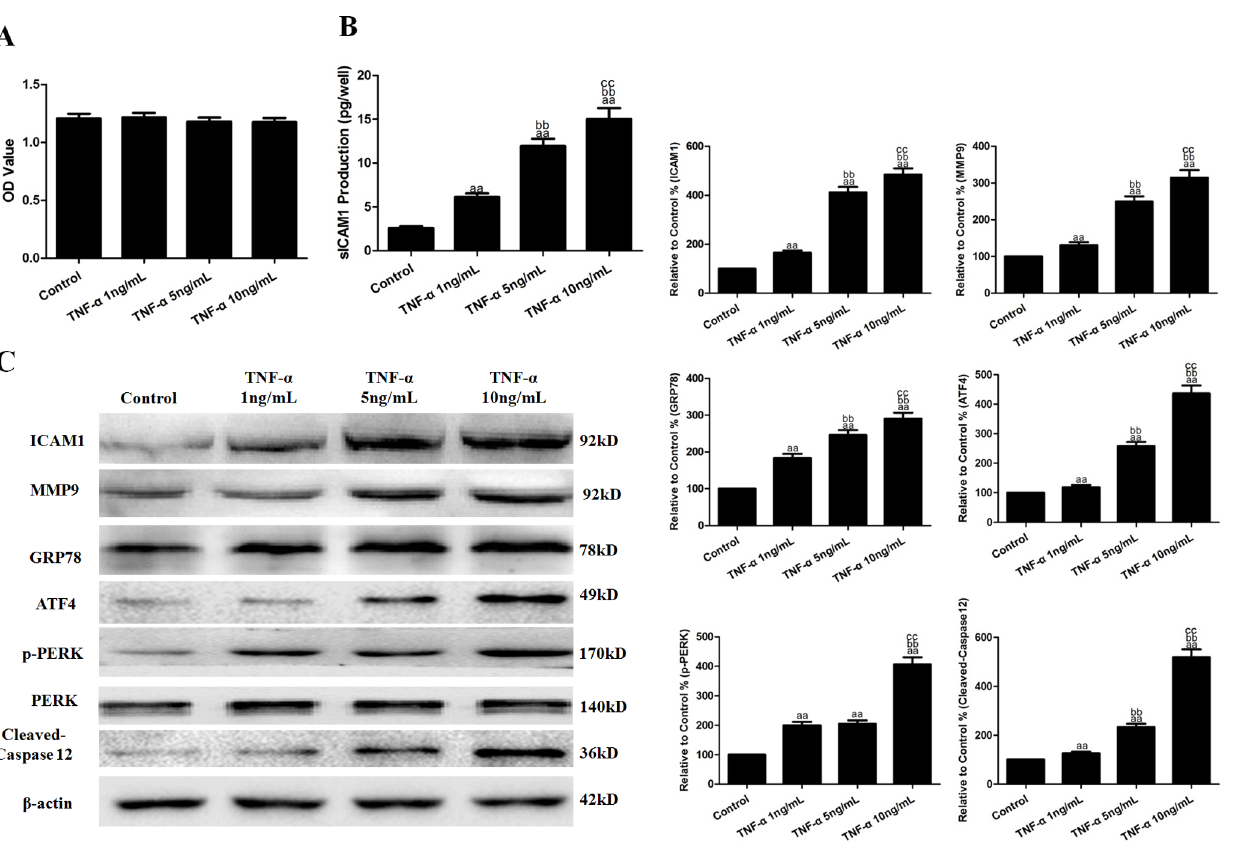
Figure 1. Effects of TNF- a on cell viability, inflammatory cytokines and ERS-related molecules. A. Cell viability is expressed as an OD value. B. The levels of sICAM1 in cell culture supernatants. C. Representative Western blot results showing ICAM1, MMP9, GRP78, ATF4, cleaved-caspase12, p-PERK and PERK protein expression. The results are expressed as the means ¡ SD, n 5 6. aa P , 0.01, compared with the control group; bb P , 0.01, compared with the 1 ng/mL TNF- a group; cc P , 0.01, compared with the 5 ng/mL TNF- a group. EP, ethyl pyruvate; OD, optical density.